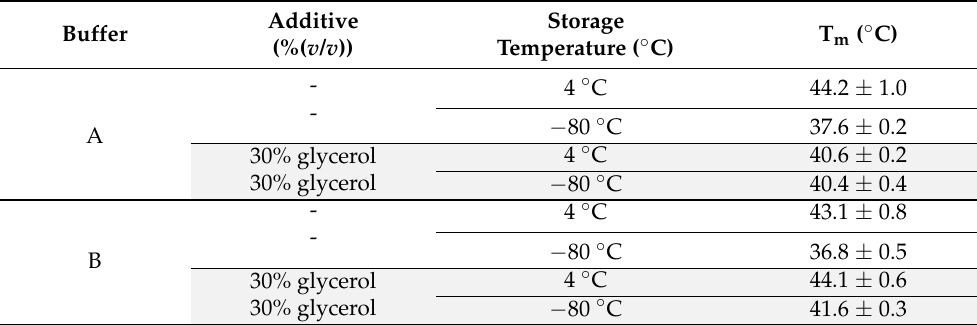
Table 1. Influence of glycerol on Tm values of hSCOMT when in storage at 4 ◦ C and − 80 ◦